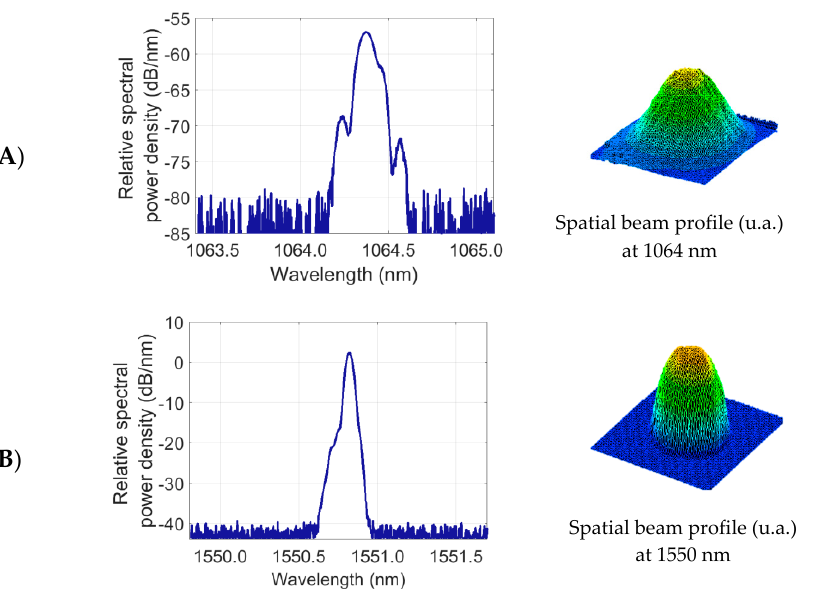
Figure 5. Spectra and spatial profiles of the interacting waves: ( A ) 1064 nm beam at the cavity output and ( B ) 1550 nm beam before 2D spatial modulation.